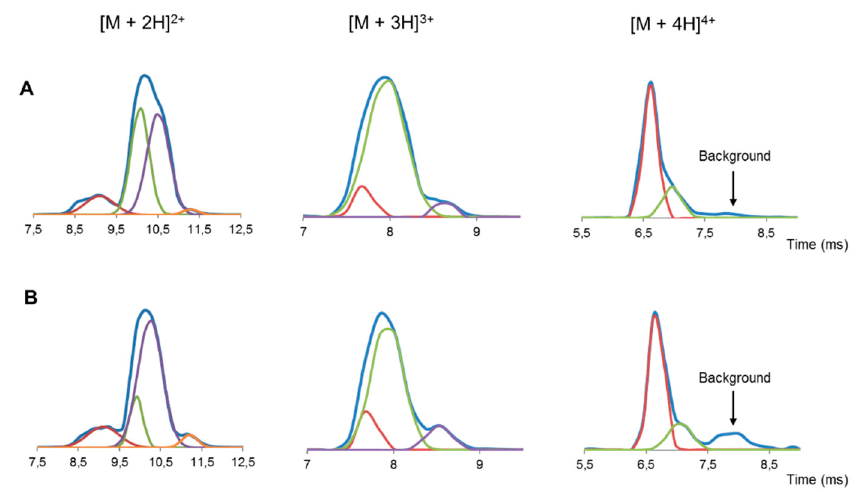
Figure 3. Drift times profiles (blue trace) and fitted peaks (red, green, purple and orange trace) of double, triple and quadruple protonated ion of ( A ) the new compound obtained after treatment with a base and ( B ) native MccJ25. Background is the residual drift time profile, in which no more peaks could be fitted.